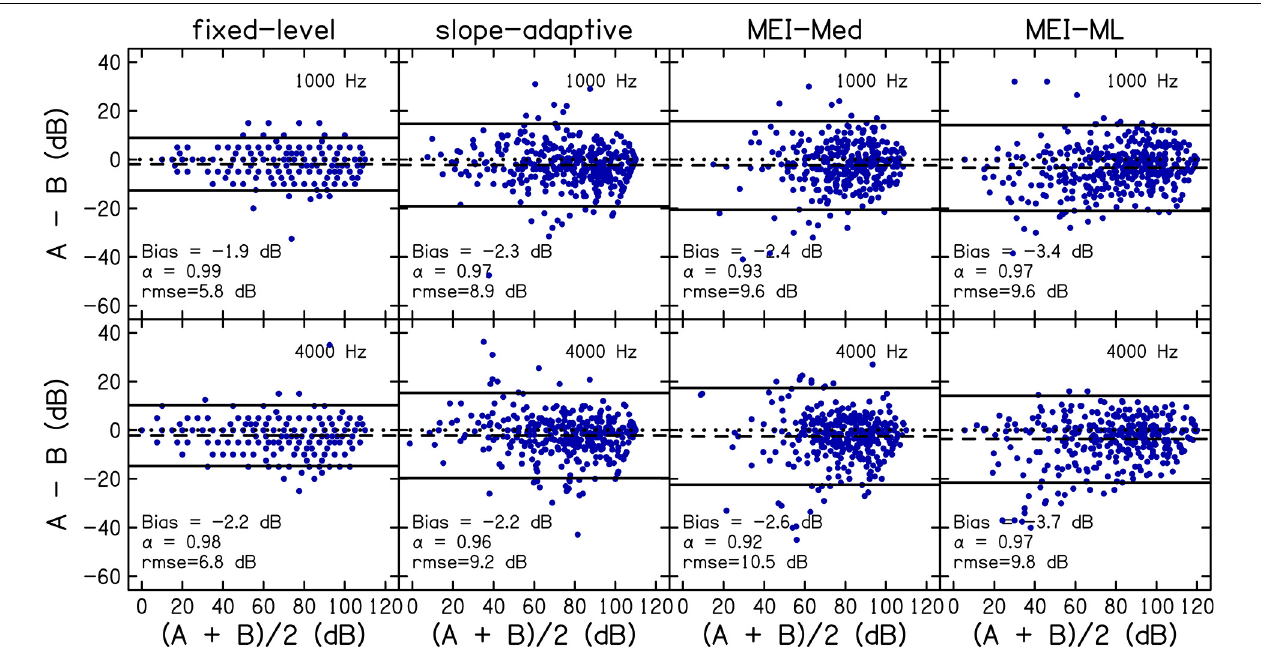
FIGURE 5 | Reliability was assessed by comparing data for visit 1 to visit 2. Panels are Bland-Altman plots for each CLS procedure at 1 (top row) and 4 kHz (bottom row). A = visit 1; B = visit2. Data points represent the difference between visits (A–B; y -axis) compared to the mean of both visits [(A + B)/2; x -axis]. The dashed line represents the bias. For references, a difference of zero is indicated using a dotted line. The solid lines represent the 95% limits of agreement. Values of Bland-Altman bias, Cronbach’s α , and root-mean-square errors (rmse) are displayed as insets in each panel and in Table 5 .